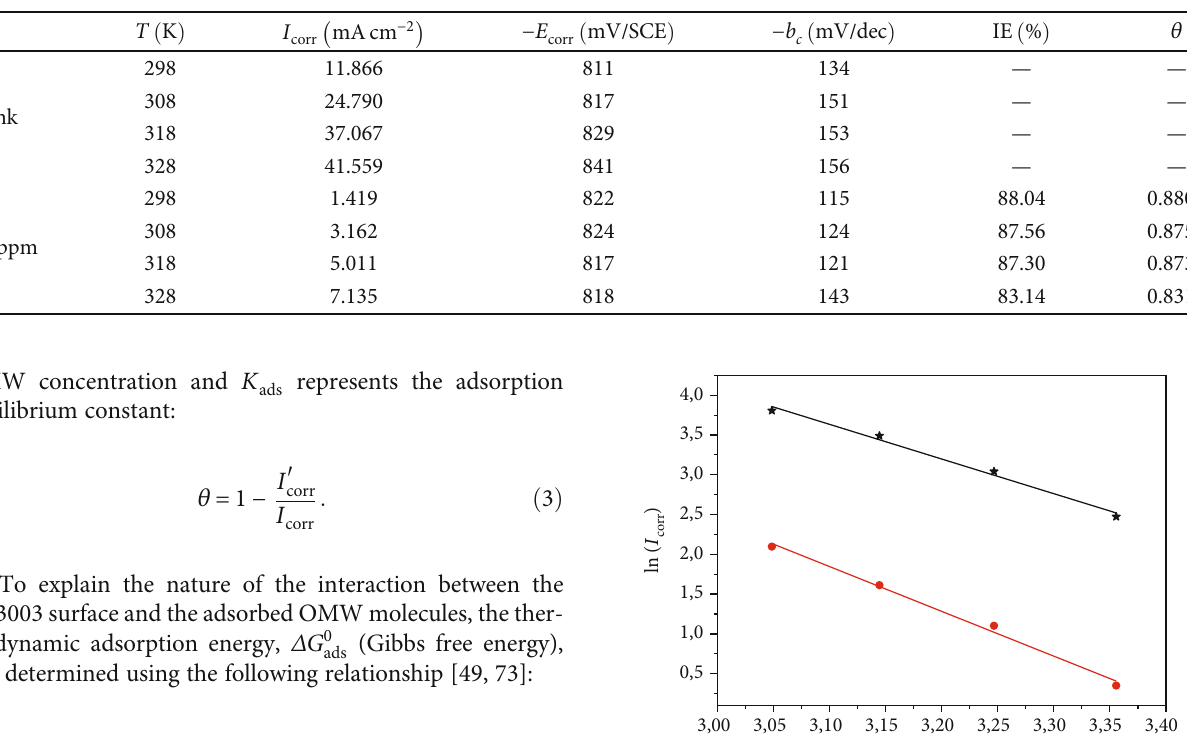
Figure 5: Polarization curves of AA3003 alloy in 1 M HCl medium (a) without and (b) with addition of 6.0 ppm OMW at di ff erent temperatures. Table 6: Derived polarization electrochemical parameters of AA3003 alloy in 1 M HCl medium in the absence and presence of 6.0ppm OMW at di ff erent temperatures.